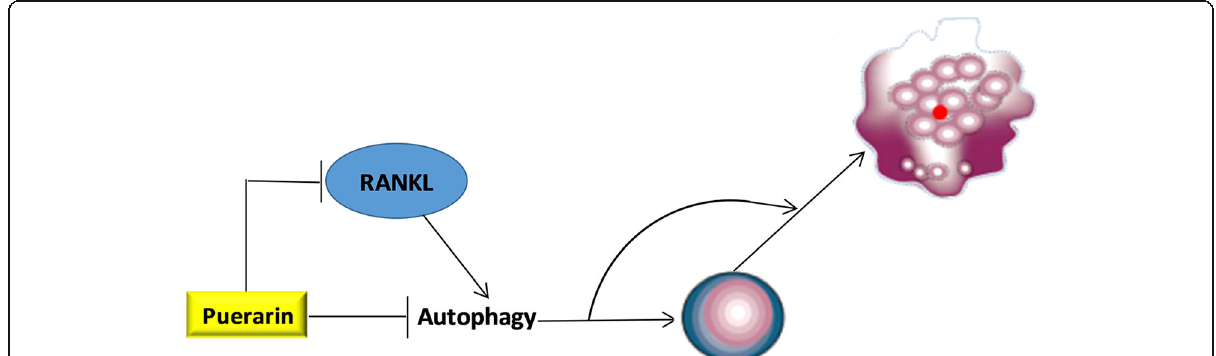
Fig. 5 The current working model regarding Puerarin-regulated autophagy during the